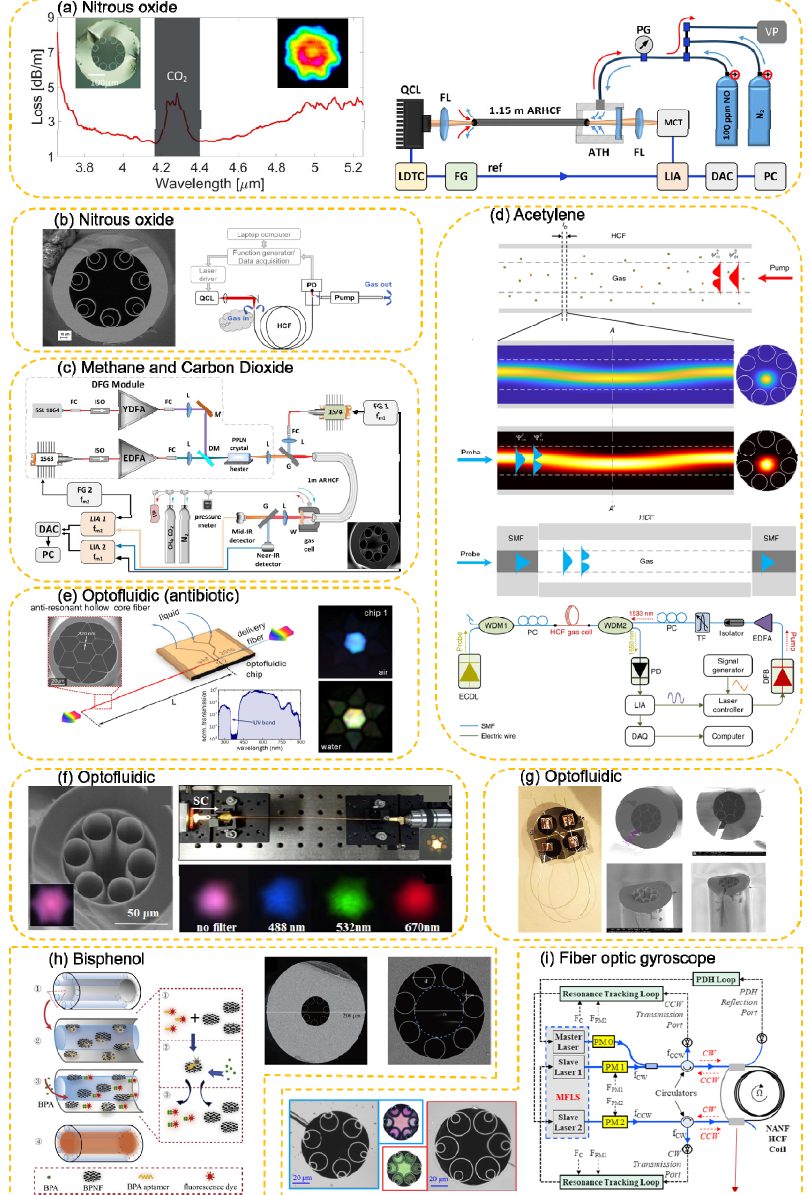
Figure 5. Versatile platform based sensing applications. ( a ) [Reprinted/Adapted] with permis- sion from [58] © The Optical Society. ( b ) [Reprinted/Adapted] with permission from [59] © The Optical Society. ( c ) Reproduced with permission [60]. Copyright 2020 MDPI. ( d ) Reproduced with permission [61]. Copyright 2020, Springer Nature. ( e ) Reproduced with permission [62]. Copyright 2018 MDPI. ( f ) [Reprinted/Adapted] with permission from [63] © The Optical Society. ( g ) [Reprinted/Adapted] with permission from [64] © The Optical Society. ( h ) Reproduced with permission [65]. Copyright 2020, Elsevier. ( i ) [Reprinted/Adapted] with permission from [66] © The Optical